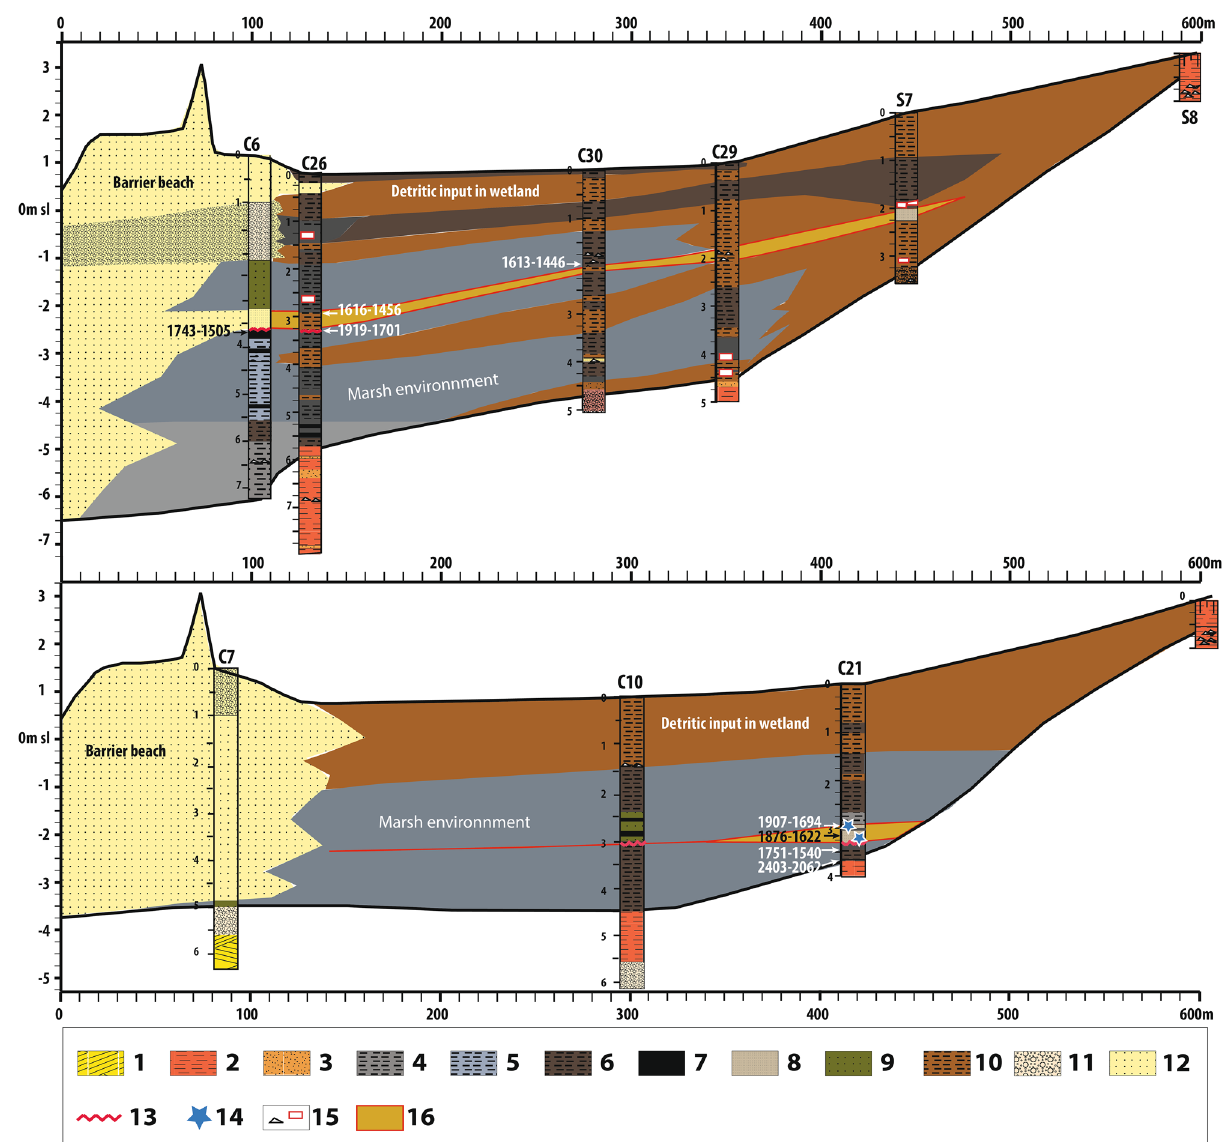
Figure 2. Longitudinal stratigraphy of the Malia marsh and the position of the Late Minoan high energy event, its absolute chronology data (in years BCE). 1. Pleistocene calcarenites; 2. Pleistocene red-ochre sandy silt; 3. Pleistocene gravel and sand; 4. Holocene dark grey organic silty clay (gyttja); 5. Holocene dark grey-blue silty clay; 6. Dark brown silt; 7. Peaty silt; 8. Silty sand layer; 9. Greenish grey sandy clay; 10. Light brown silt; 11. Coarse sand, gravels and stones; 12. Medium grain-size beach and dune sand; 13. Sharp sedimentary contact; 14. Marine microfaunal elements; 15. Limestone fragments (black triangle) and potsherds (red box); 16. Silty or sandy sediments attributable to the time period of the Late Minoan high energy northeast (Fig. 2). These are interpreted as the sedimentation of an elongated marsh fed by intermittent streams behind a coastal barrier formed during the Holocene marine transgression (Fig. 3a, dark applet 7). From 3000 to 2000 years BCE, an extension of the blue-grey to dark-grey silty organic sedimentation occurs landward along two depressions separated by an elongated hill, south of cores C29 and C21, testifying the development of the wetland (Fig. 3a). These conditions lasted until the beginning of the Late Minoan (LM) period, circa 1630–1525 years BCE. After the eruption (Fig. 3b), the development of dark grey to greenish grey silty organic sedimentation shows a landward progression of the marsh southwest into its current form (Figs. 2 and 3b). From the 1st Millennium BC onwards, the wetland stabilized, with only minor changes. C21 core. In most cores, macroscopic observations of stratigraphy and sedimentary facies failed to show evidence of a high-energy sedimentary event. Core C21, however, to the west of the southern end of the marsh shows a clear signal (Fig. 4). Analysis of the transition from U3 to U5 reveals an abrupt change in the sedimen- tary facies (Fig. 5). U4 has a sharp basal contact showing an abrupt erosional event with truncation of the under-